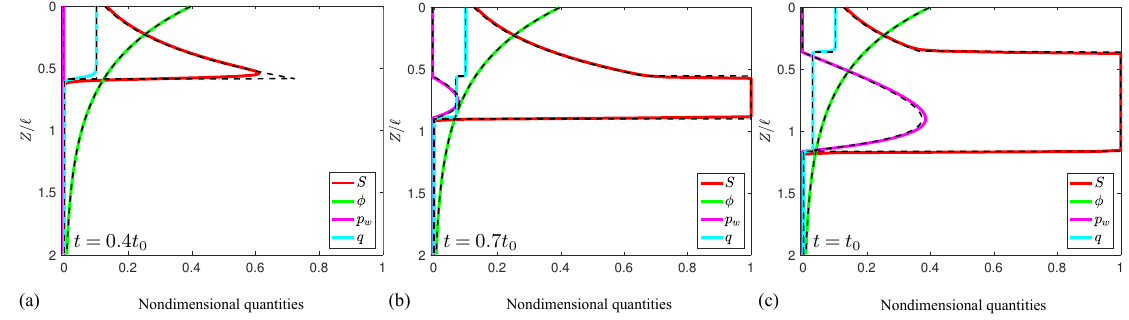
Figure 5. Evolution of fully saturated fronts at three instances in time, showing saturation (red), water flux (cyan), and water pressure (magenta). The porosity (green) decreases exponentially with depth over length scale Z 0 = `/ 2 , where ` is the characteristic length scale defined in Appendix B and given in table 1. Panel (a) shows the position of the front before the firn fully saturates. Panels (b) and (c) show the bidirectional motion of the fully saturated fronts. Dashed black lines show semi-analytical solutions from solving equation (41).